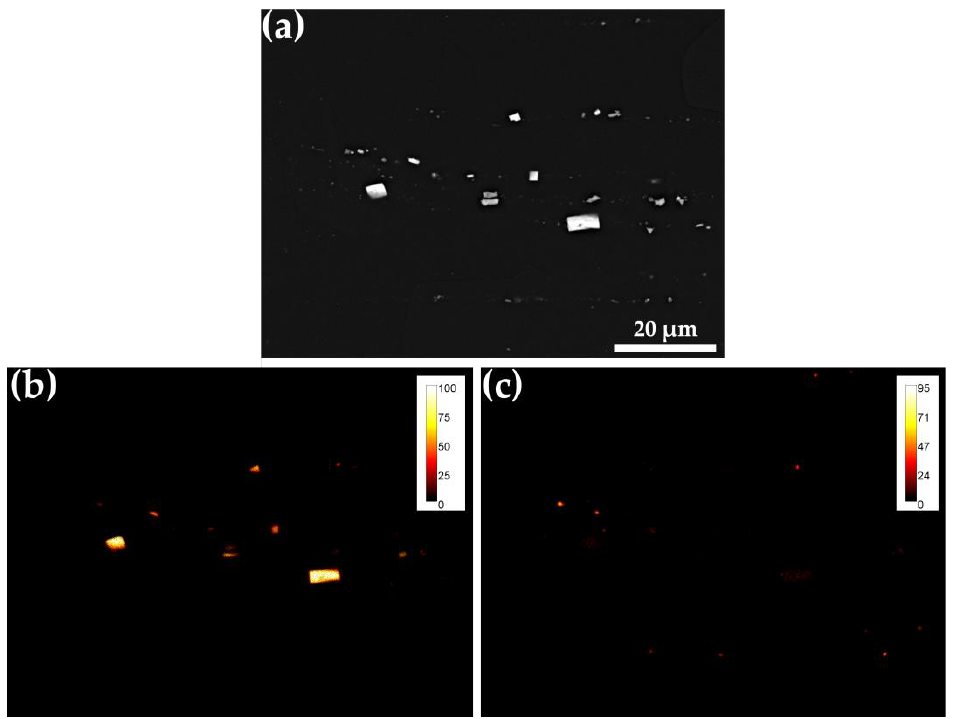
Figure 6. Mg-9Gd-1Mn extruded at 450 °C/2.2 mm/s in ( a ) SE mode with ( b ) Gd and ( c ) Mn element maps in wt.%. Gd-rich with distinct rectangular shape present and small Mn-rich particles (pure Mn).